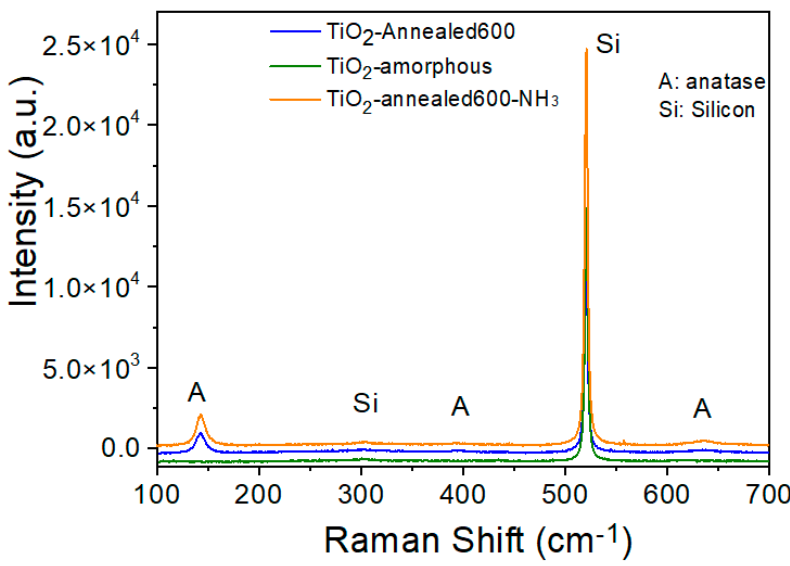
Figure 2. Raman spectra of the TiO 2 films with amorphous, annealed, and N-doped annealed phases.